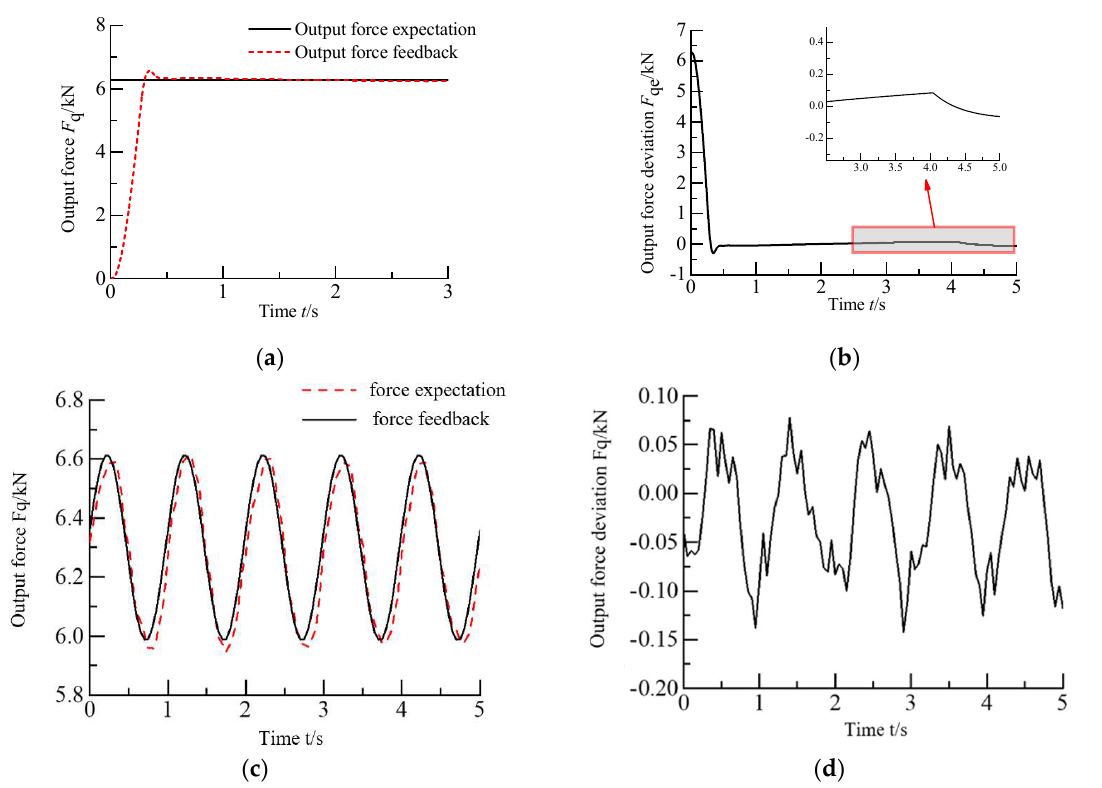
Figure 17. Simulation curve of force control. ( a ) Step output force response curve. ( b ) Step output force error curve. ( c ) Sinusoidal output force response curve. ( d ) Sinusoidal output force error curve.